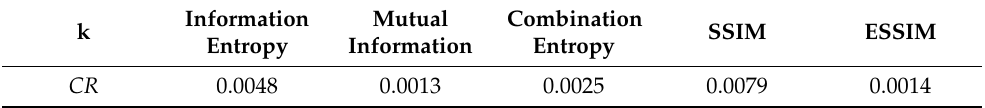
Table 2. Consistency index of the five evaluation